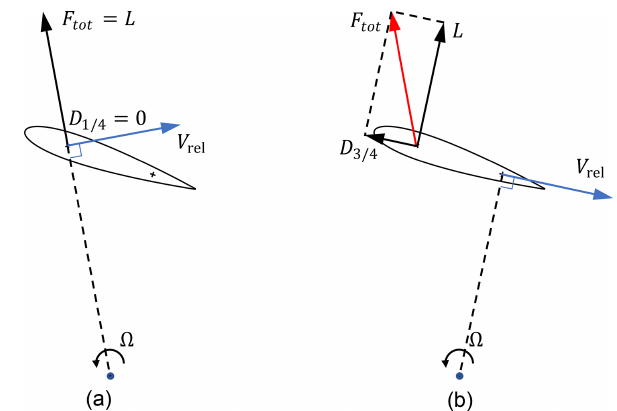
Figure B1. Illustration of two correct methods of defining the di- rection of the lift and drag forces for a VAWT. (a) Correctly using D 1 / 4 and relative direction at the quarter-chord point. (b) Correctly using D 3 / 4 ( < 0) and relative direction at the three-quarter-chord point. The total force vector in the two cases is